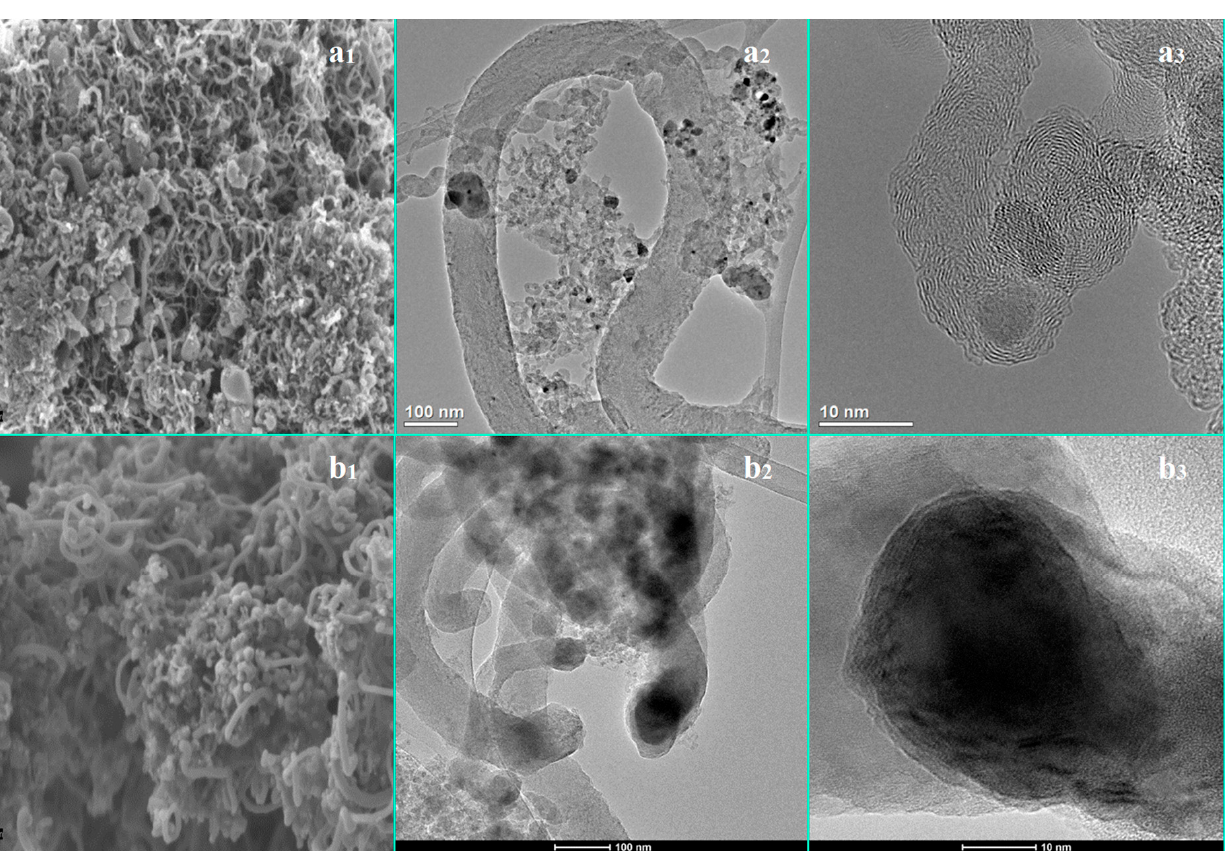
Figure 7. Microscopic analysis of Ni/MnO x catalyst after 18 h of SRE reaction at 420 °C for ( a ) H 2 O/EtOH molar ratio of 12/1 and ( b ) H 2 O/EtOH molar ratio of 4/1. SEM images ( a 1 , b 1 ) and TEM images ( a 2 , a 3 , b 2 , b 3 ).